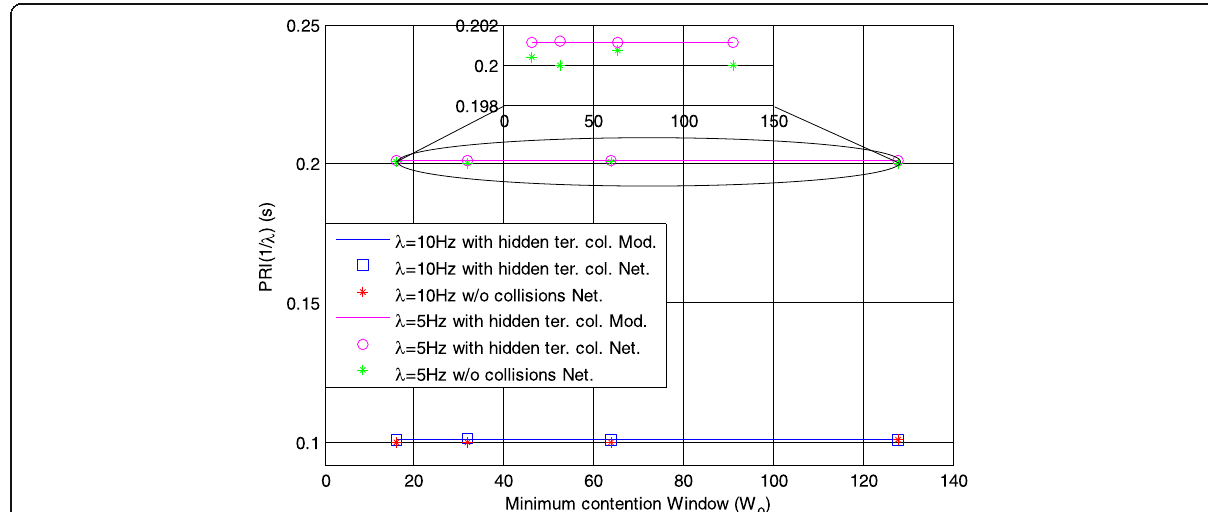
Fig. 20 PRI for analytical model and real network in Fig. 8 (Net.) for hidden terminal collisions and without collisions with respect to minimum contention window sizes for different packet generation frequencies, R = 6 Mbps, D = 186 B, R c = 250